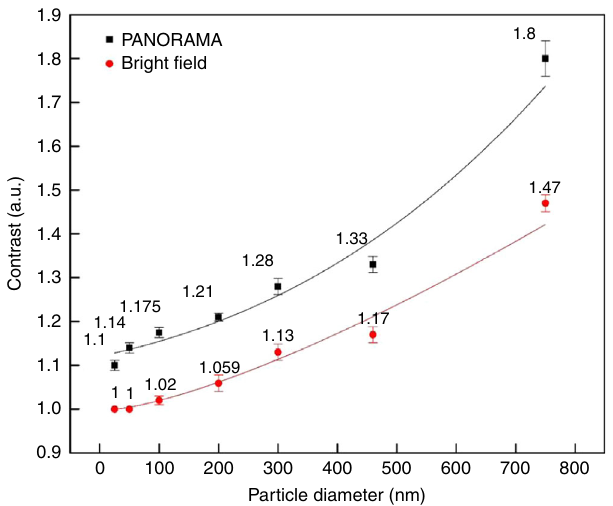
Fig. 3 IR vs. nanoparticle diameter via PANORAMA (black squares) and by bright- fi eld microscopy (red circles). The curves are provided for visual guidance. The averages and error bars were calculated from the points used to plot histograms in Fig. 2.